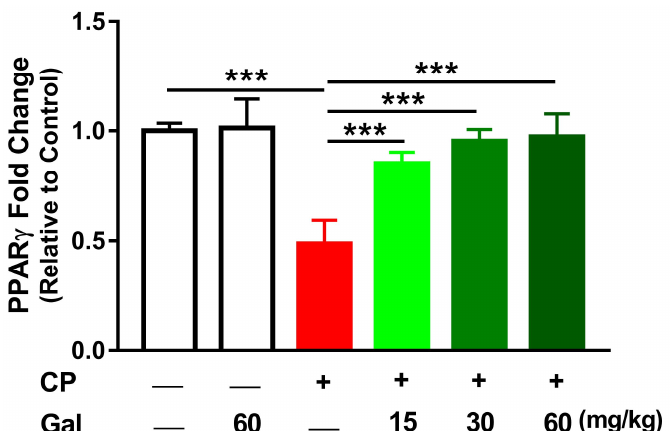
Figure 9. Galangin (Gal) increases peroxisome proliferator activated receptor gamma (PPAR γ ) expression in liver of CP-intoxicated rats. Data are mean ± SEM, ( N = 6). *** P < 0.001.